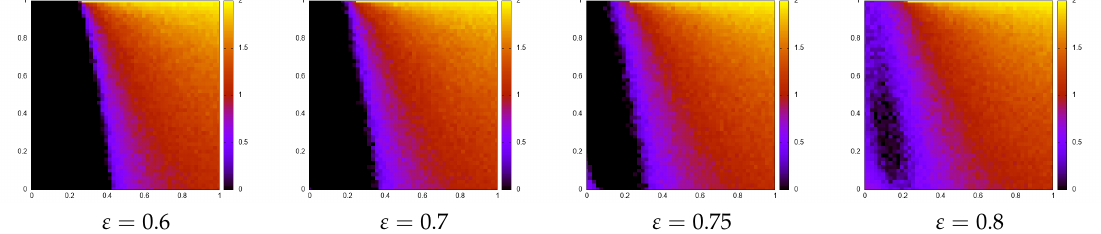
Figure 5. Phase space of directed percolation with interacting colors, case (a). The vertical axes is p and the horizontal one is q . For moderate values of ε one simply has a shift of the critical line, but for ε ≥ 0.75 a region near the corner p = q = 0 becomes active.